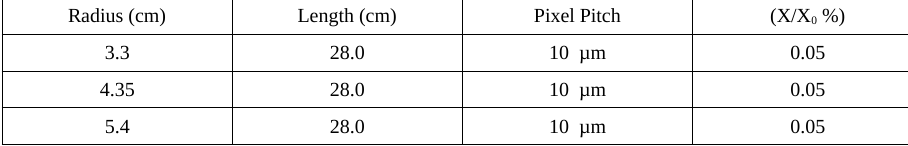
Table 1. The geometric parameters of Silicon Vertex Layers [10].